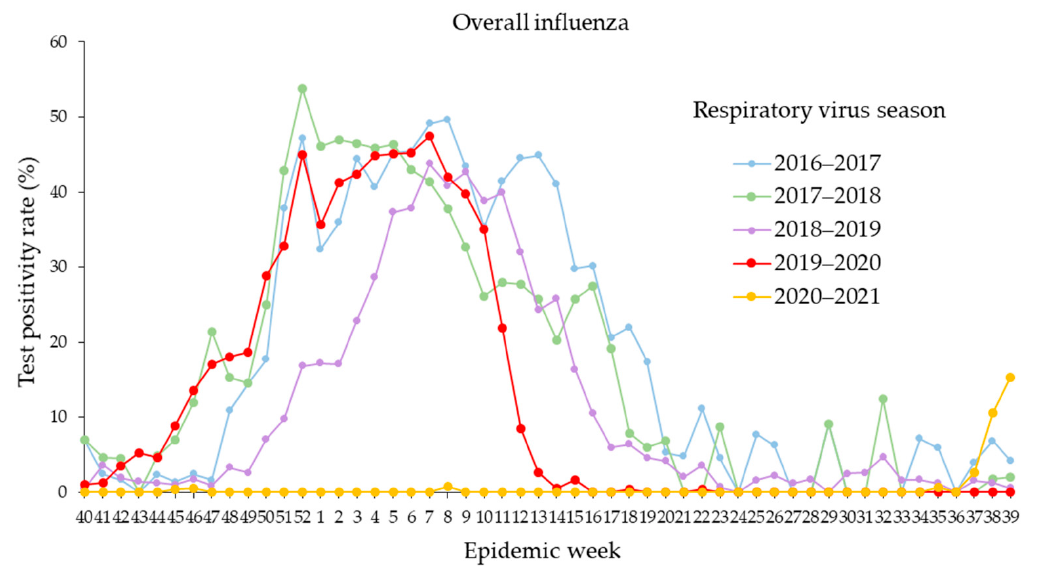
Figure 2. Seasonal activity of overall influenza including influenza A(H1N1)pdm09, influenza A(H3N2), and influenza B in respiratory seasons from 2016–2017 to 2020–2021. Epidemic week is the week of the epidemiologic year for which there is the National Notifiable Diseases Surveillance System (NNDSS) disease report, the United States. There are 53 weeks exceptionally in the 2020–2021 season, the positivity rate of overall influenza in week 53 was zero, and not shown in graph.